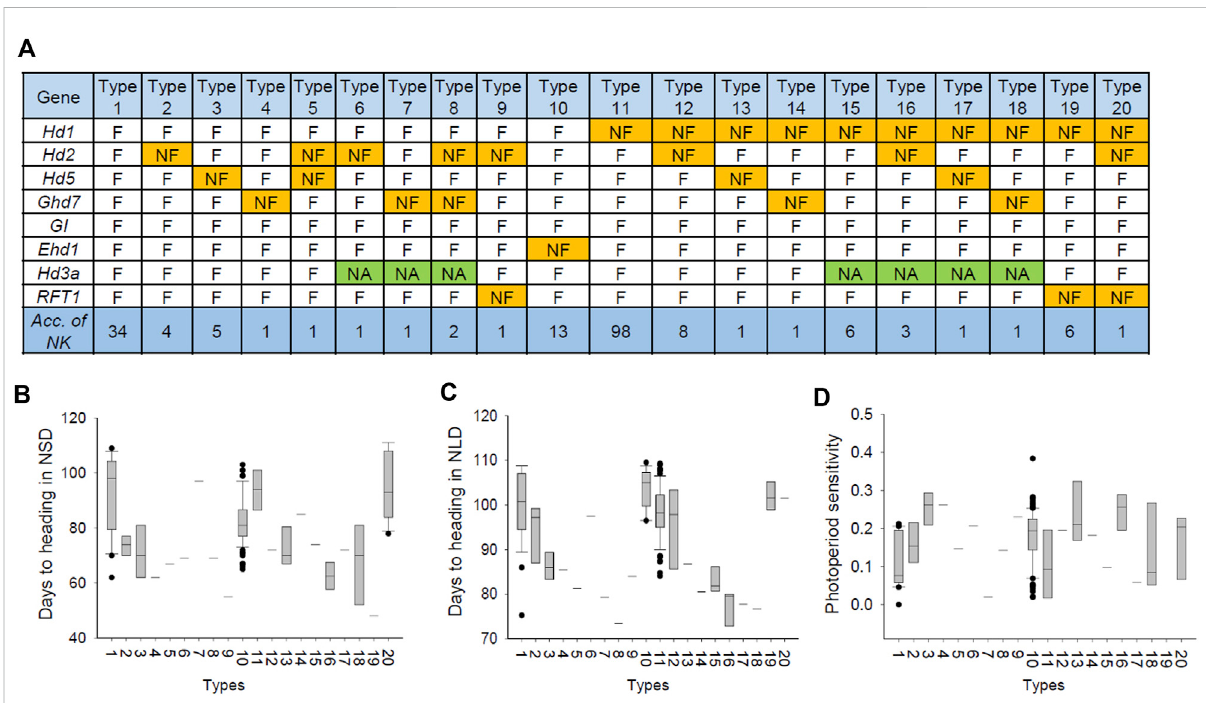
FIGURE 7 Allelic composition ofmajor Hdgenes regulating days to heading in the190 NK rice accessions. (A) Haplotypecombinationof major Hd genes. (B) Phenotypic variation between the types of Hd genes combination in NSD conditions. (C) Phenotypic variation between the types of Hd genes combination in NLD conditions. (D) Phenotypic variation between the types of Hd genes combination in